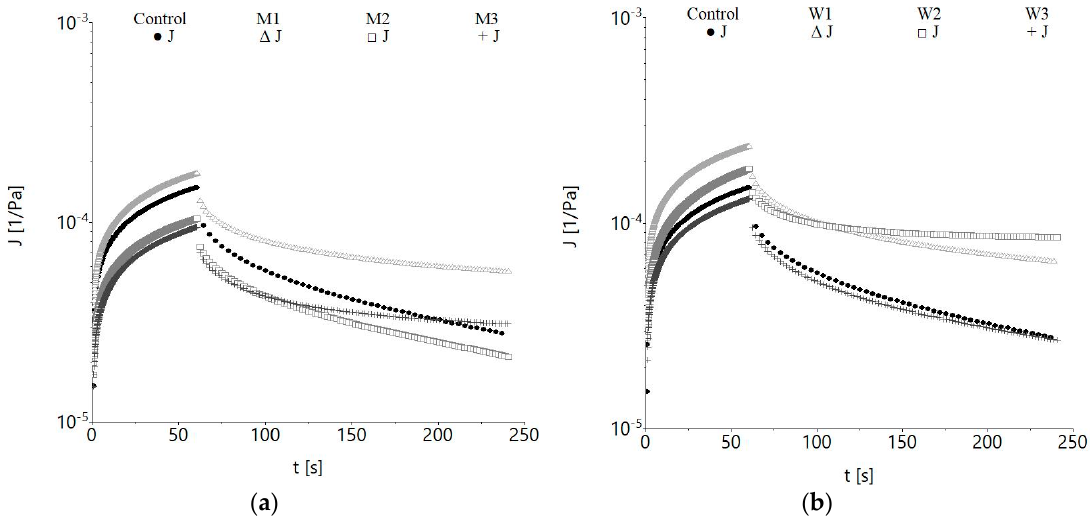
Figure 2. Creep and recovery curves of wheat flour dough at different water replacement levels by: ( a ) milk: M1—12.5%, M2—25%, M3—50%, ( b ) acid whey: W1—12.5% W2—25% W3—50%.